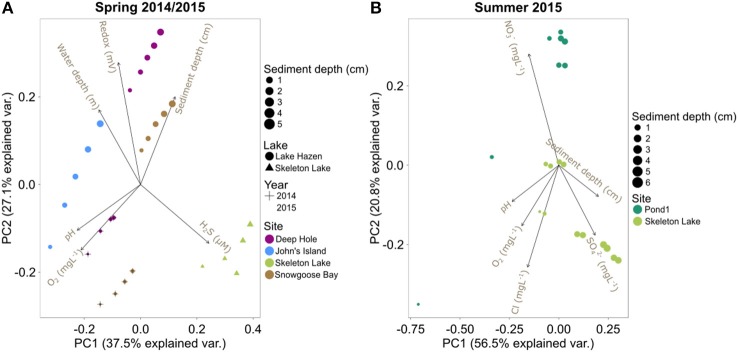
PCA biplots of the physicochemical variables in: (A) spring 2014/2015 samples, and (B) summer 2015 samples.